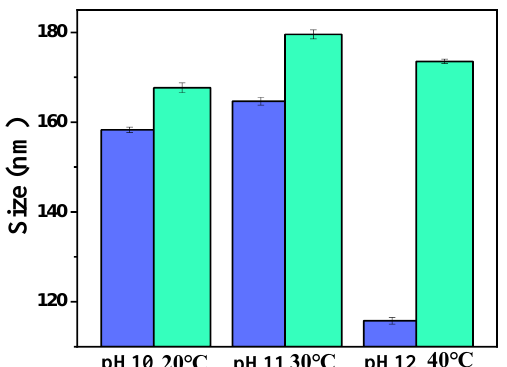
Figure 1. Sizes of mesoporous polydopamine (MPDA) nanoparticles at different pH values and temperatures (Number of samples (n) =